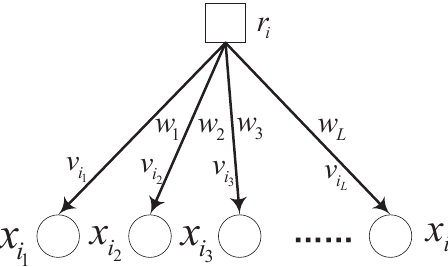
Figure 3. Symbol node conveys message to its all neighboring variable nodes.